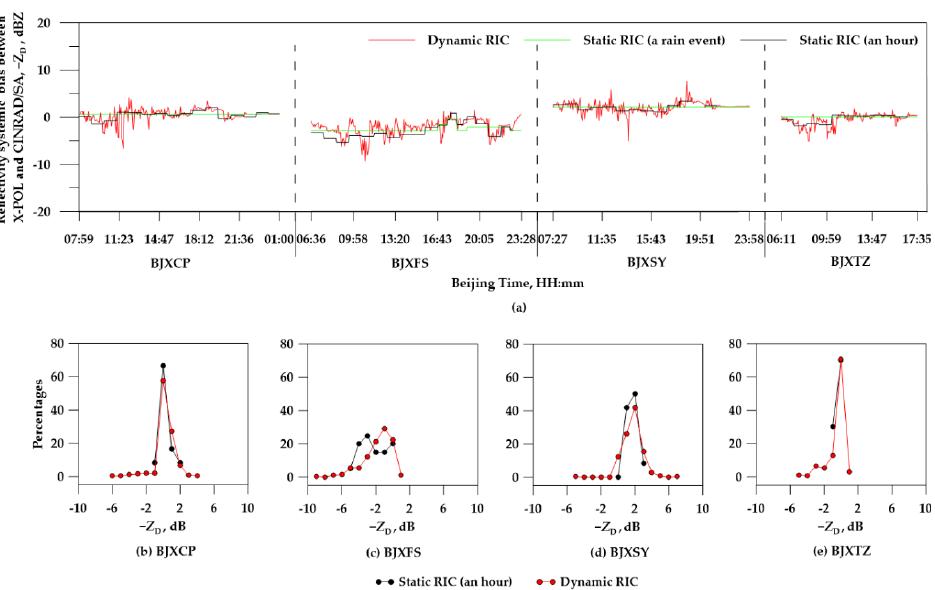
Figure 7. ( a ) Temporal variations of systemic reflectivity bias between X-POL and CINRAD/SA radars (− Z D ) in the rain event on 20 July 2016. The statistics for variable ranges of − Z D at four X-POL radar sites: ( b ) BJXCP, ( c ) BJXFS, ( d ) BJXSY, and ( e ) BJXTZ.